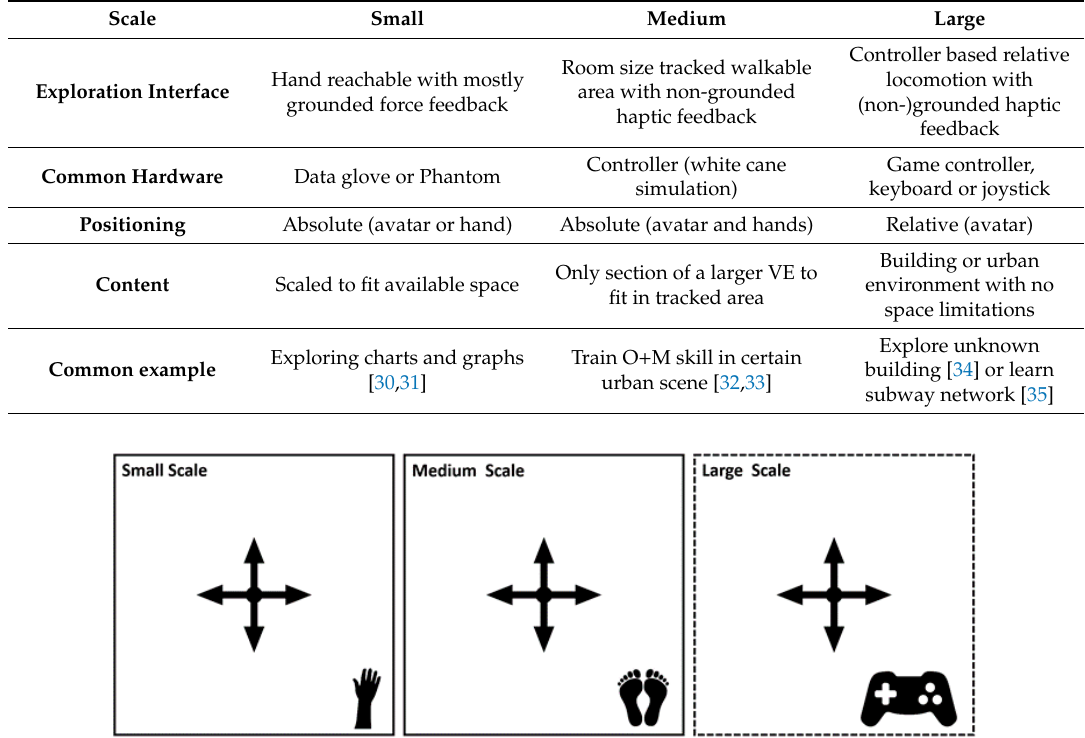
Figure 3. Schematic representation of the distinction between small, medium and large-scale based on the users’ interface for spatial exploration. Table 1. Definition and example of small, medium and large-scale according to parameters of the respective VEs to classify existing related work.